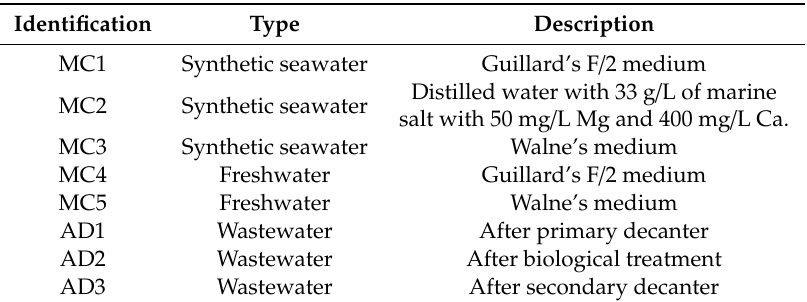
Table 1. Cultivation media 1 .